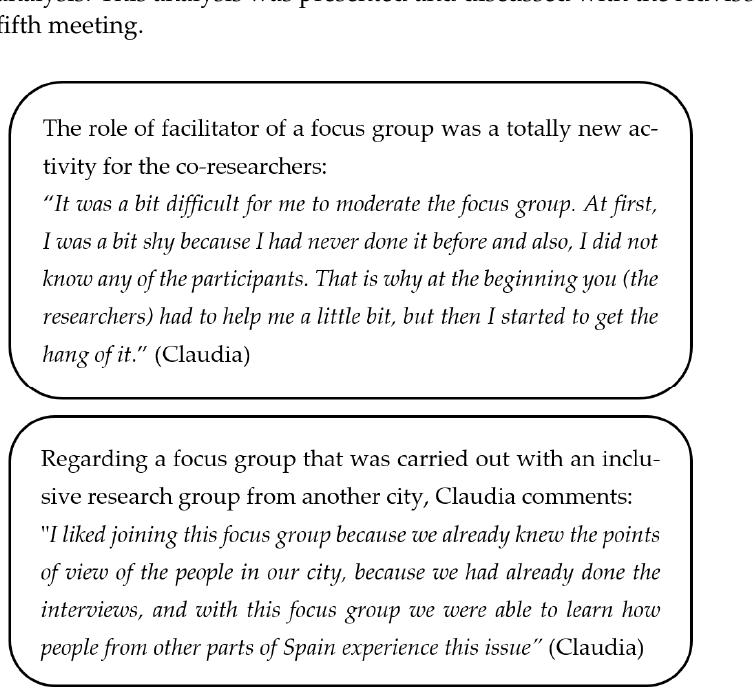
Figure 4. Co-researcher’s opinions 8, 9.